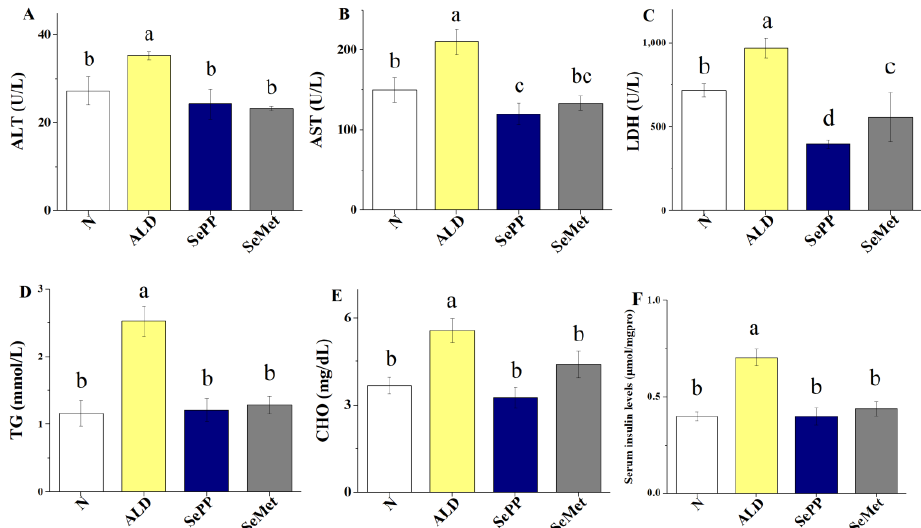
Figure 5. Hepatic lipid and serum insulin levels in mice. Levels of ALT ( A ), AST ( B ), LDH ( C ), TG ( D ), CHO ( E ) and serum insulin levels ( F ). Data are expressed as mean ± SEM ( n = 9). Different letters denote significant differences between groups ( p < 0.05) (the same in Figure 6).